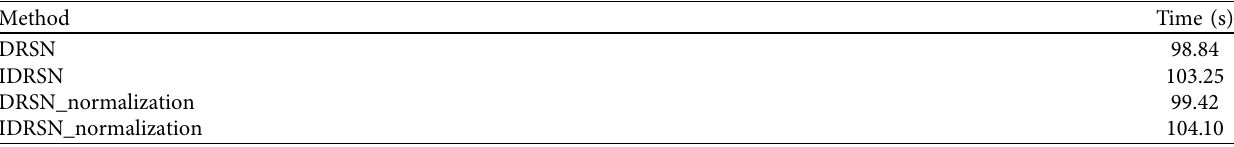
Table 5: Computational time of the considered